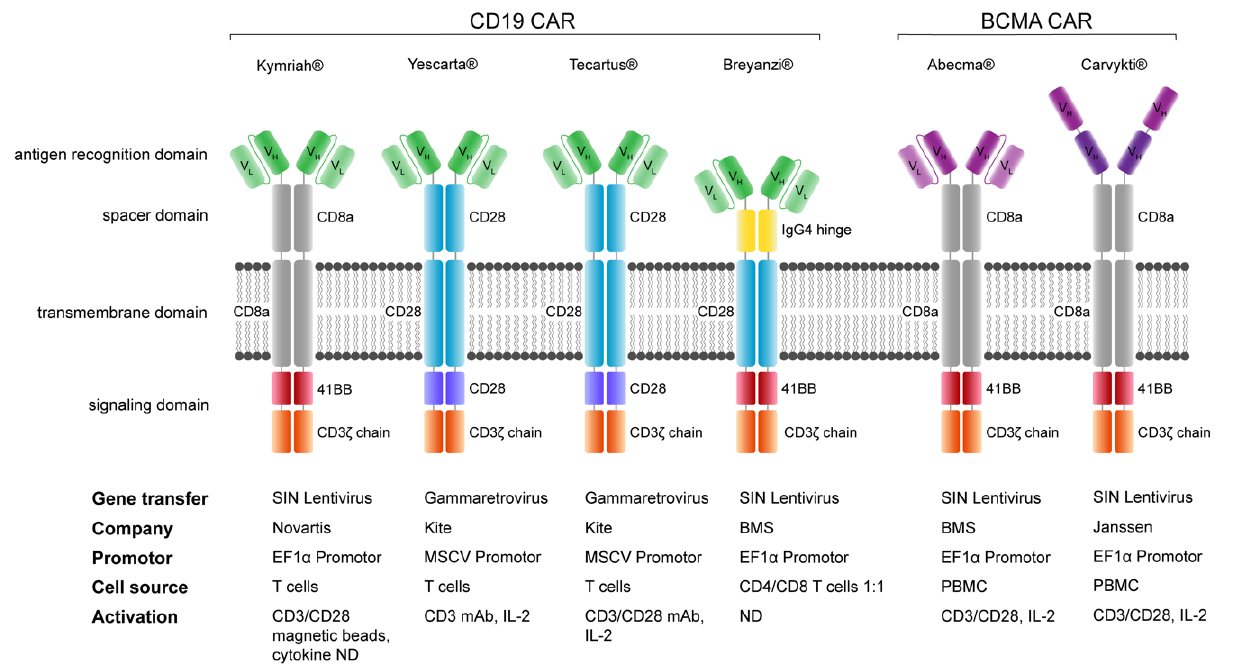
Figure 3. FDA-approved CAR T cell products.